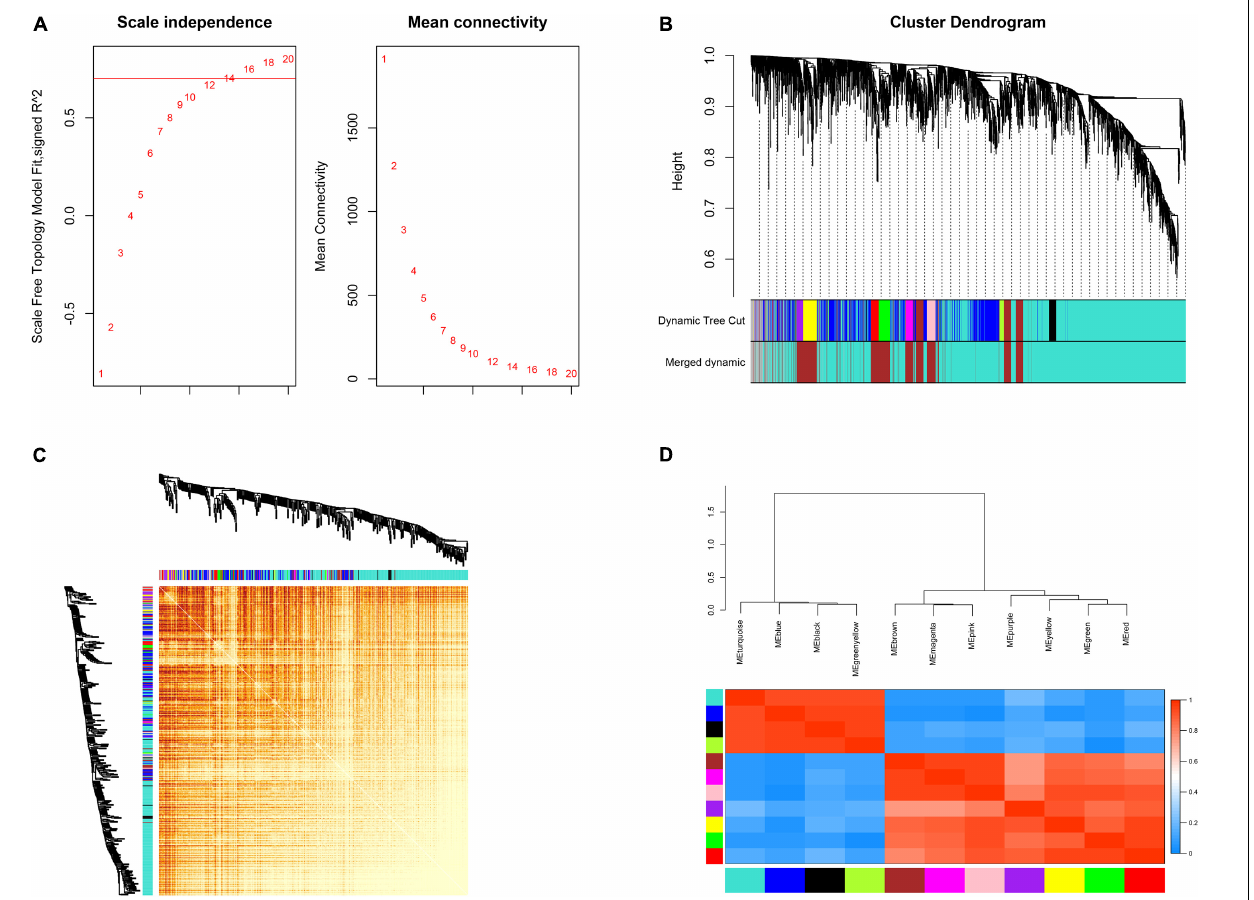
FIGURE 3 | Construction of co-expression modules. (A) Determination of soft-threshold power. (B) The cluster dendrogram of genes. Genes that could not be clustered into one of these modules were assigned to the gray module. Every gene represents a line in the hierarchical cluster. (C) Network heatmap plots of genes selected for weighted gene co-expression network analysis (WGCNA) construction. (D) Heatmap plot of the adjacencies in the eigengene